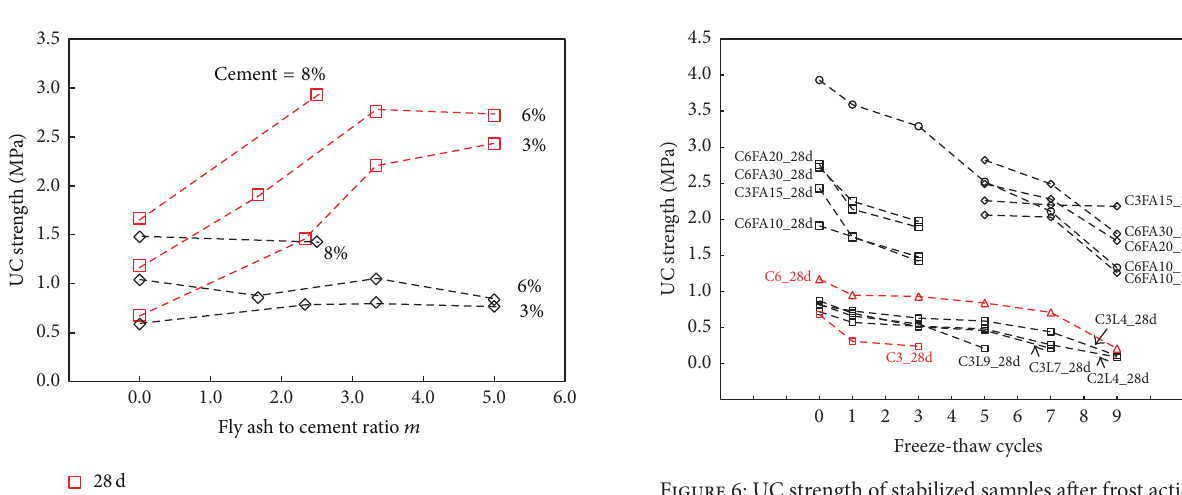
Figure 6: UC strength of stabilized samples after frost actions. strength drops different from the cement-fly ash-treated samples. The differences lie in the drop percentage versus the cycle number. The drops are on average 17.4% after the 1st cycle, 16.6% from the 1st to the 3rd cycle, 21.4% from the 3rd to the 5th cycle, 41.9% from the 5th to the 7th cycle, and 71.2% the 5th cycle—weakening earlier and worse in